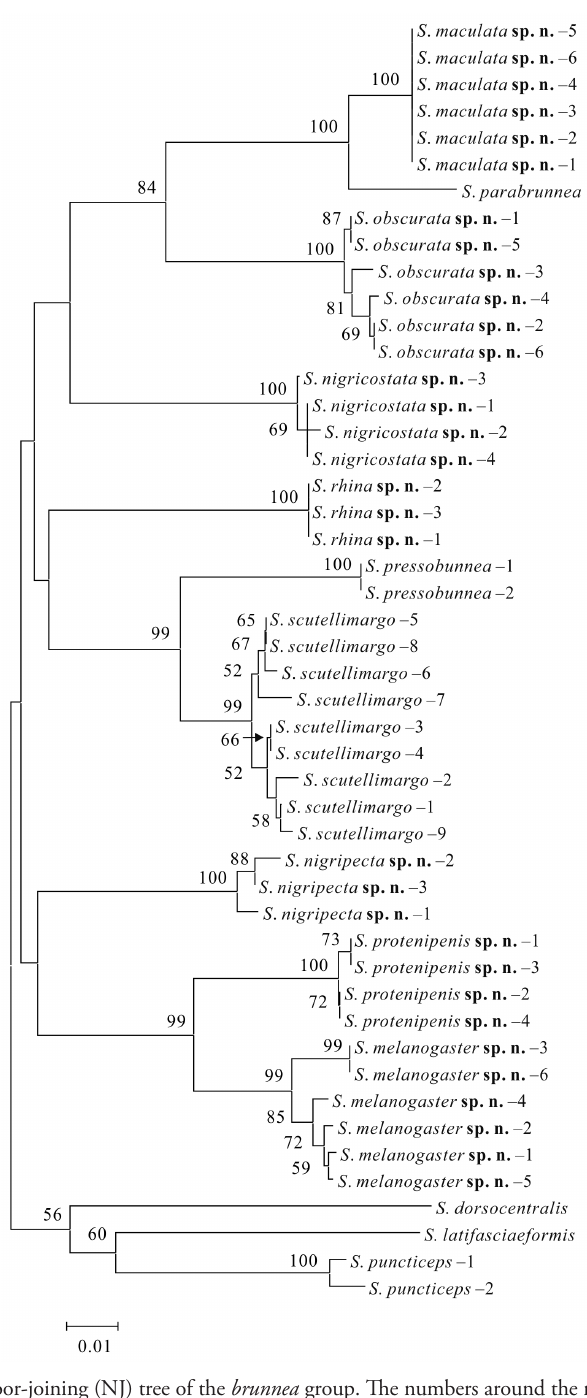
Figure 1. Neighbor-joining (NJ) tree of the brunnea group. The numbers around the nodes are bootstrap percentages (BP). BP values lower than 50 are not